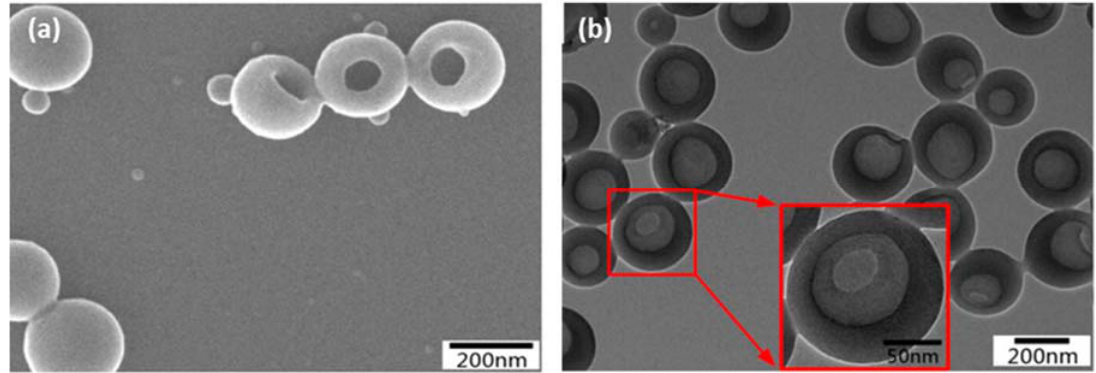
Figure 6. Image of LHNPs ( a ) SEM and ( b ) TEM (two red arrows point to an enlarged image of a selected particle) (reproduced from Ref. [4] with permission from the Elsevier).